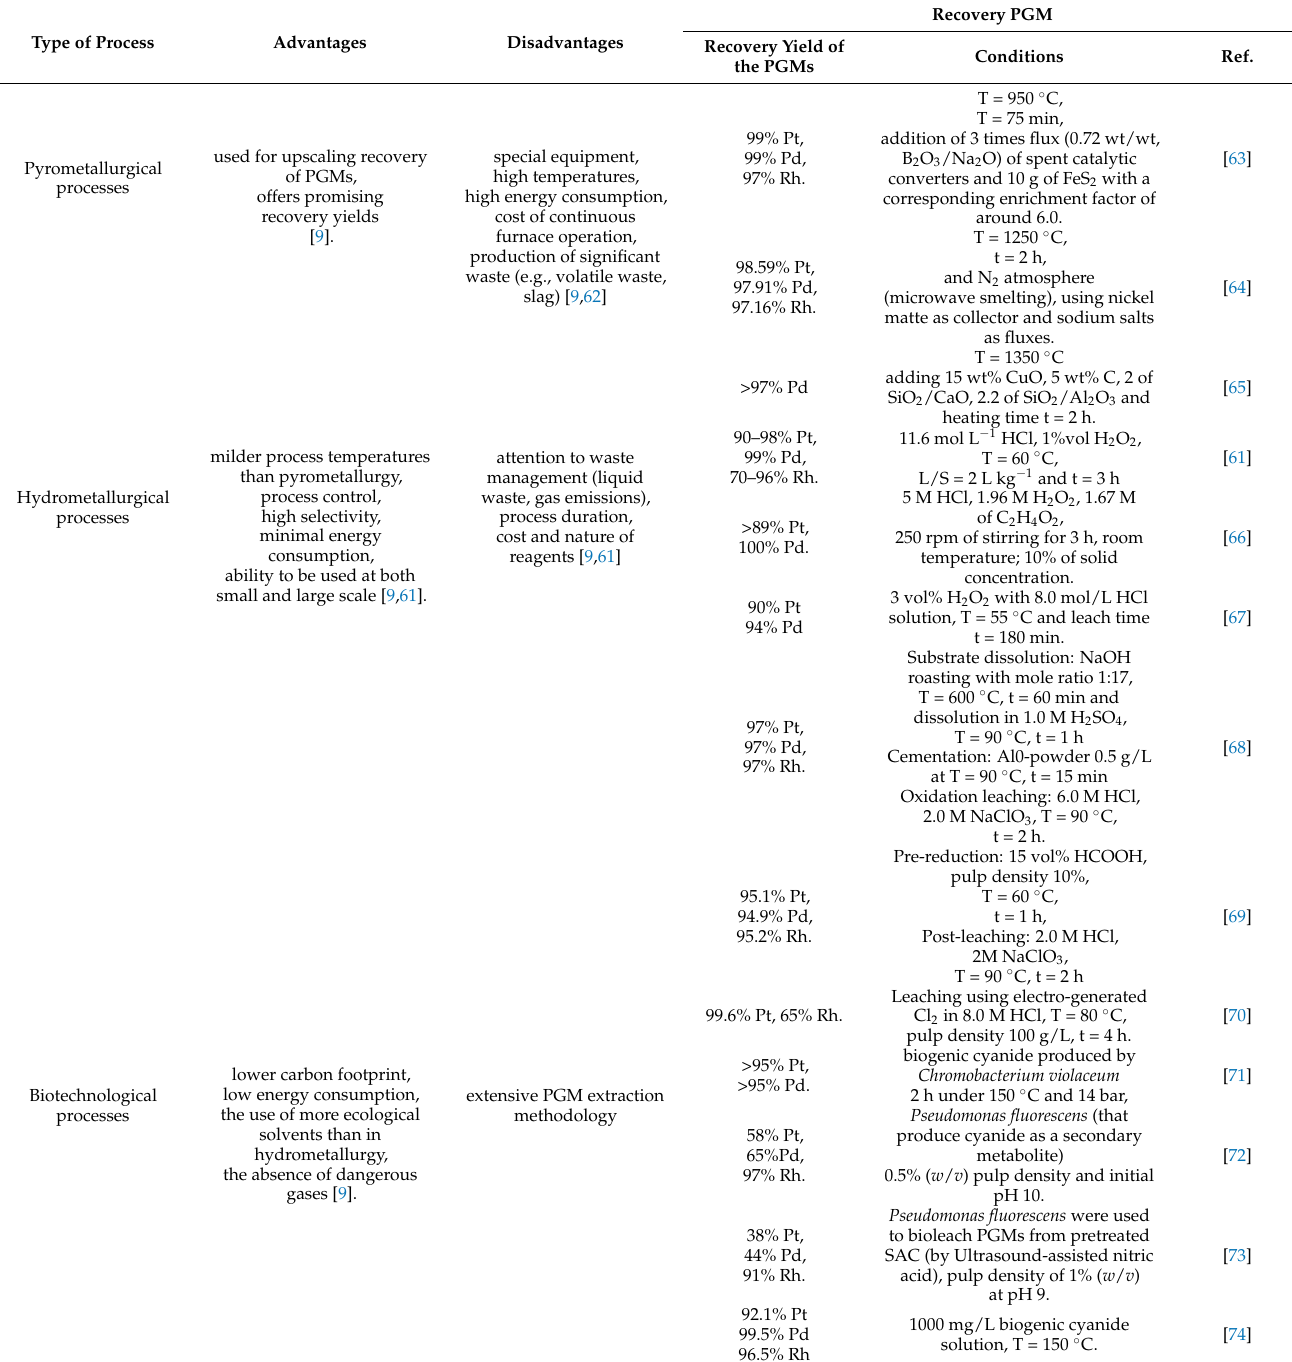
Table 2. Characteristics of metallurgical extraction